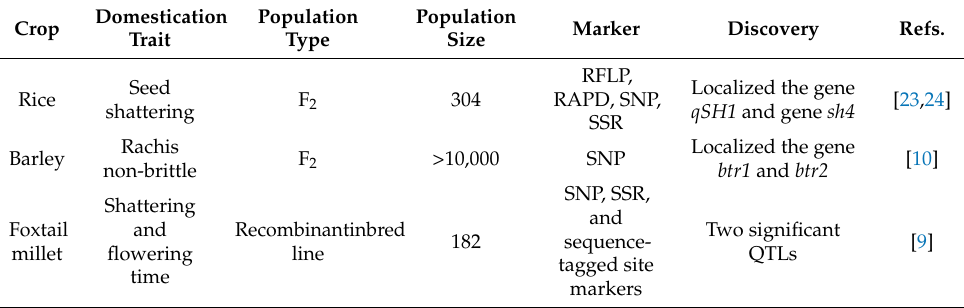
Table 3. The application of QTL to crop